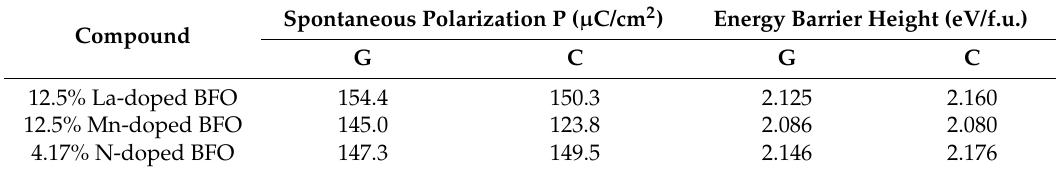
Table 3. The calculated results of one La-, Mn and N-doped 2 × 2 × 2 tetragonal BFO supercell with G-AFM and C-AFM magnetic